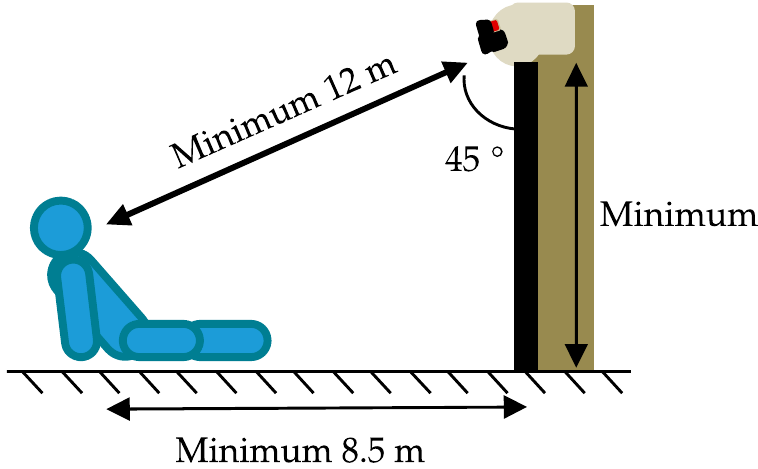
Figure 4. Sketch of the experimental setup on the floor (using static cameras).